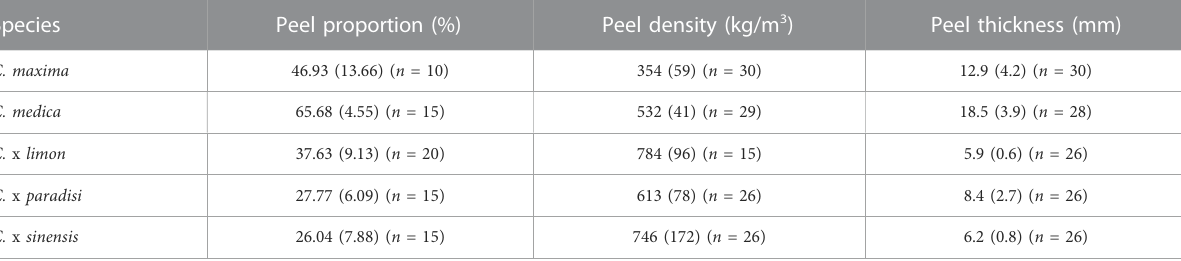
TABLE 3 Median data of the fruit and peel anatomy of Citrus spp. [pomelo ( C. maxima ), citron ( C. medica ), lemon ( C. x limon ), grapefruit ( C. x paradisi ), orange ( C. x sinensis )]. Species